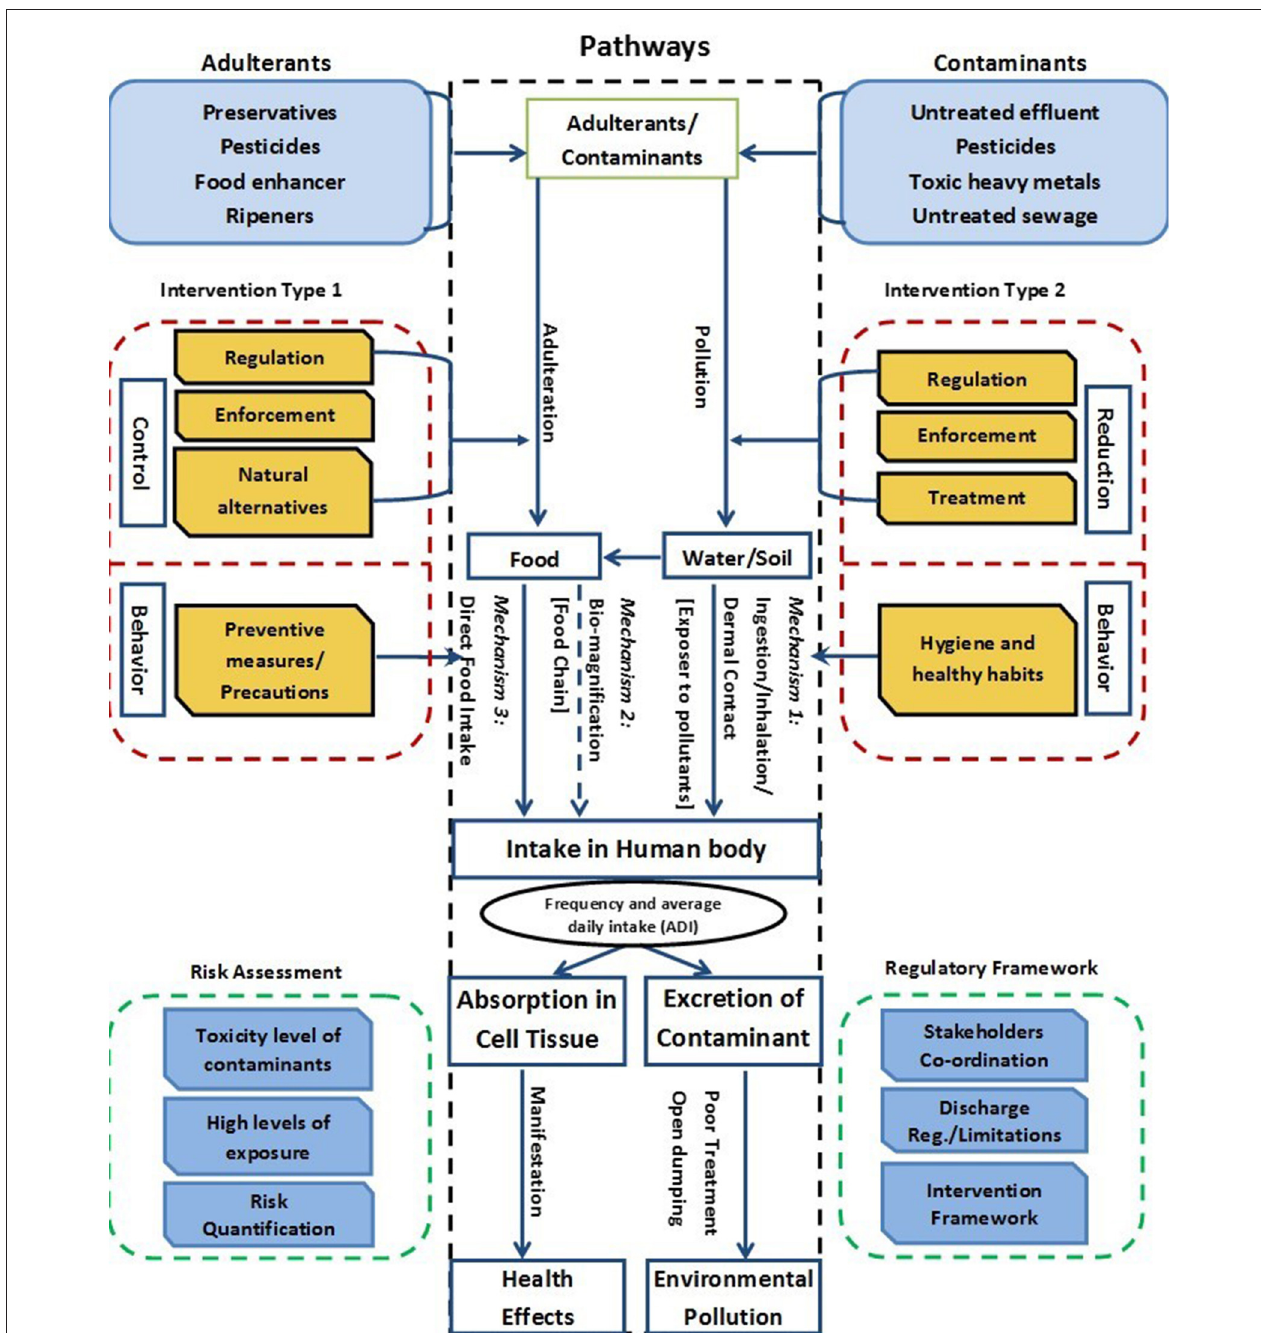
FIGURE 1 | Flow chart of human exposure to contaminant pathways and associated mechanisms involved and framework for